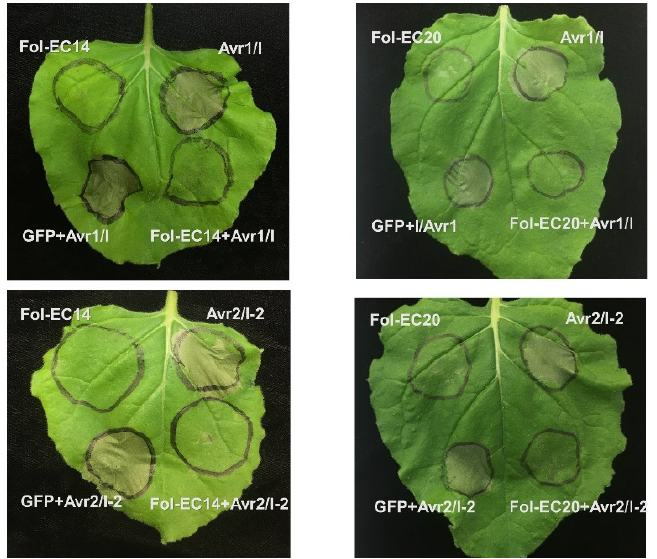
Figure 6. Fol-EC14 and Fol-EC20 can suppress cell death triggered by Fusarium-wilt resistance genes. A. tumefaciens carrying either Fol-EC14 or Fol-EC20 effector candidate gene was infiltrated into N. benthamiana leaves followed 24 h by co-infiltration with A. tumefaciens carrying the Avr1 and I or Avr2 and I-2 genes. GFP served as a negative control. Representative leaves were photographed 3 days after infiltration and the experiment was repeated at least three times with consistent results.